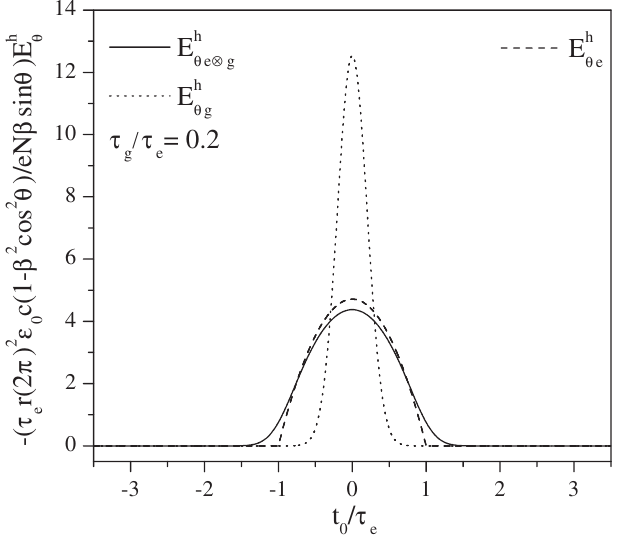
FIG. 5. Plot of the temporal electric field of the CTR pulse, for the three different electron bunches discussed in this article; the , the Gaussian ellipsoidal electron bunch with hard edges E h (cid:1)e electron bunch E h , and the ellipsoidal electron bunch with soft (cid:1)g (cid:5) 0 : 2 (cid:10) . The choice (cid:10) has been made for illus- edges E h g e (cid:1)e (cid:15) g trative